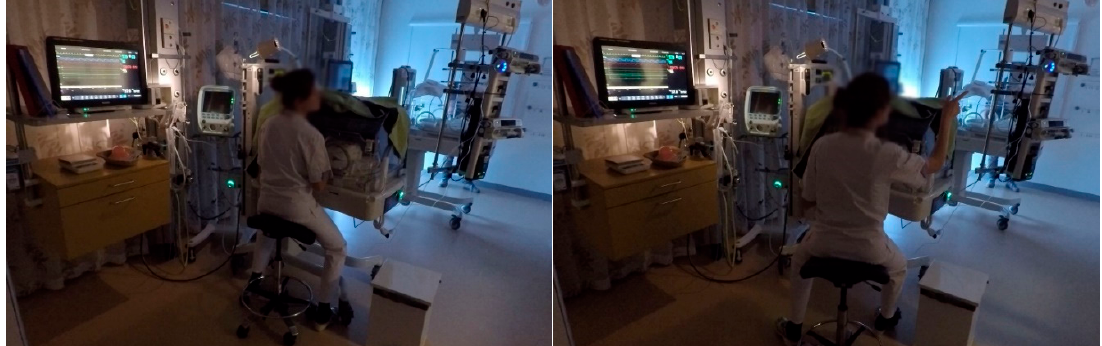
Figure 6. The moment when a participant saw the blue light of the medication syringe and realized that she could act before the alarm goes